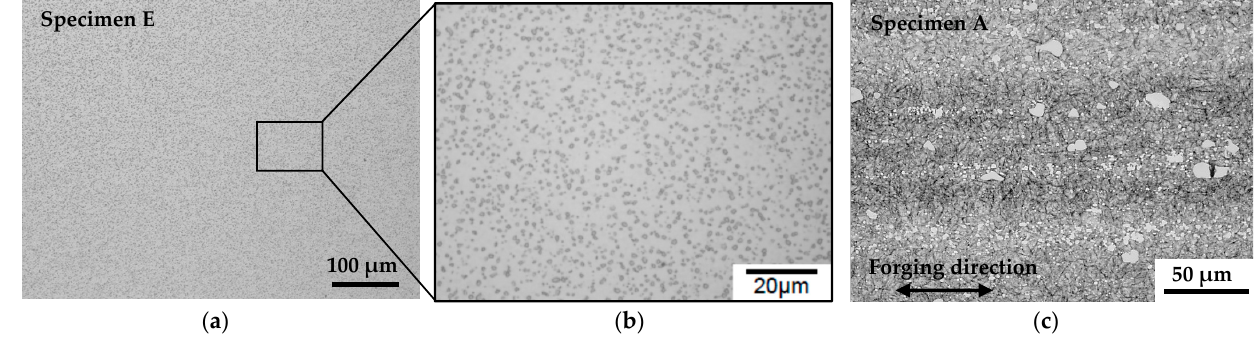
Figure 7. Microstructures of specimens E and A. No pores and fine precipitates were observed in specimen E. In specimen A, large precipitates segregated along forging direction. ( a ) 1463 K sintering with S–HIPping; ( b ) partial magnified view of panel ( a ); ( c ) cast–forged material.